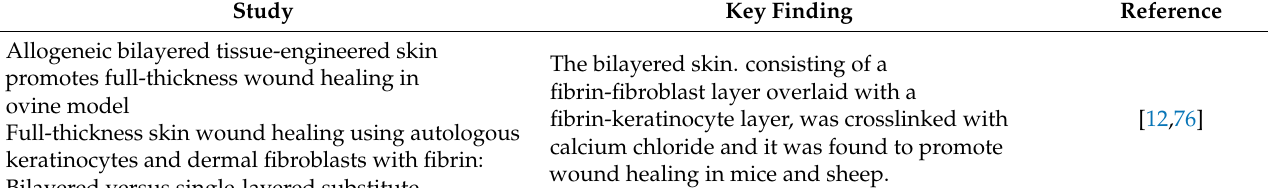
Table 4. Scaffolds loaded with calcium for skin tissue engineering purposes. Study Key